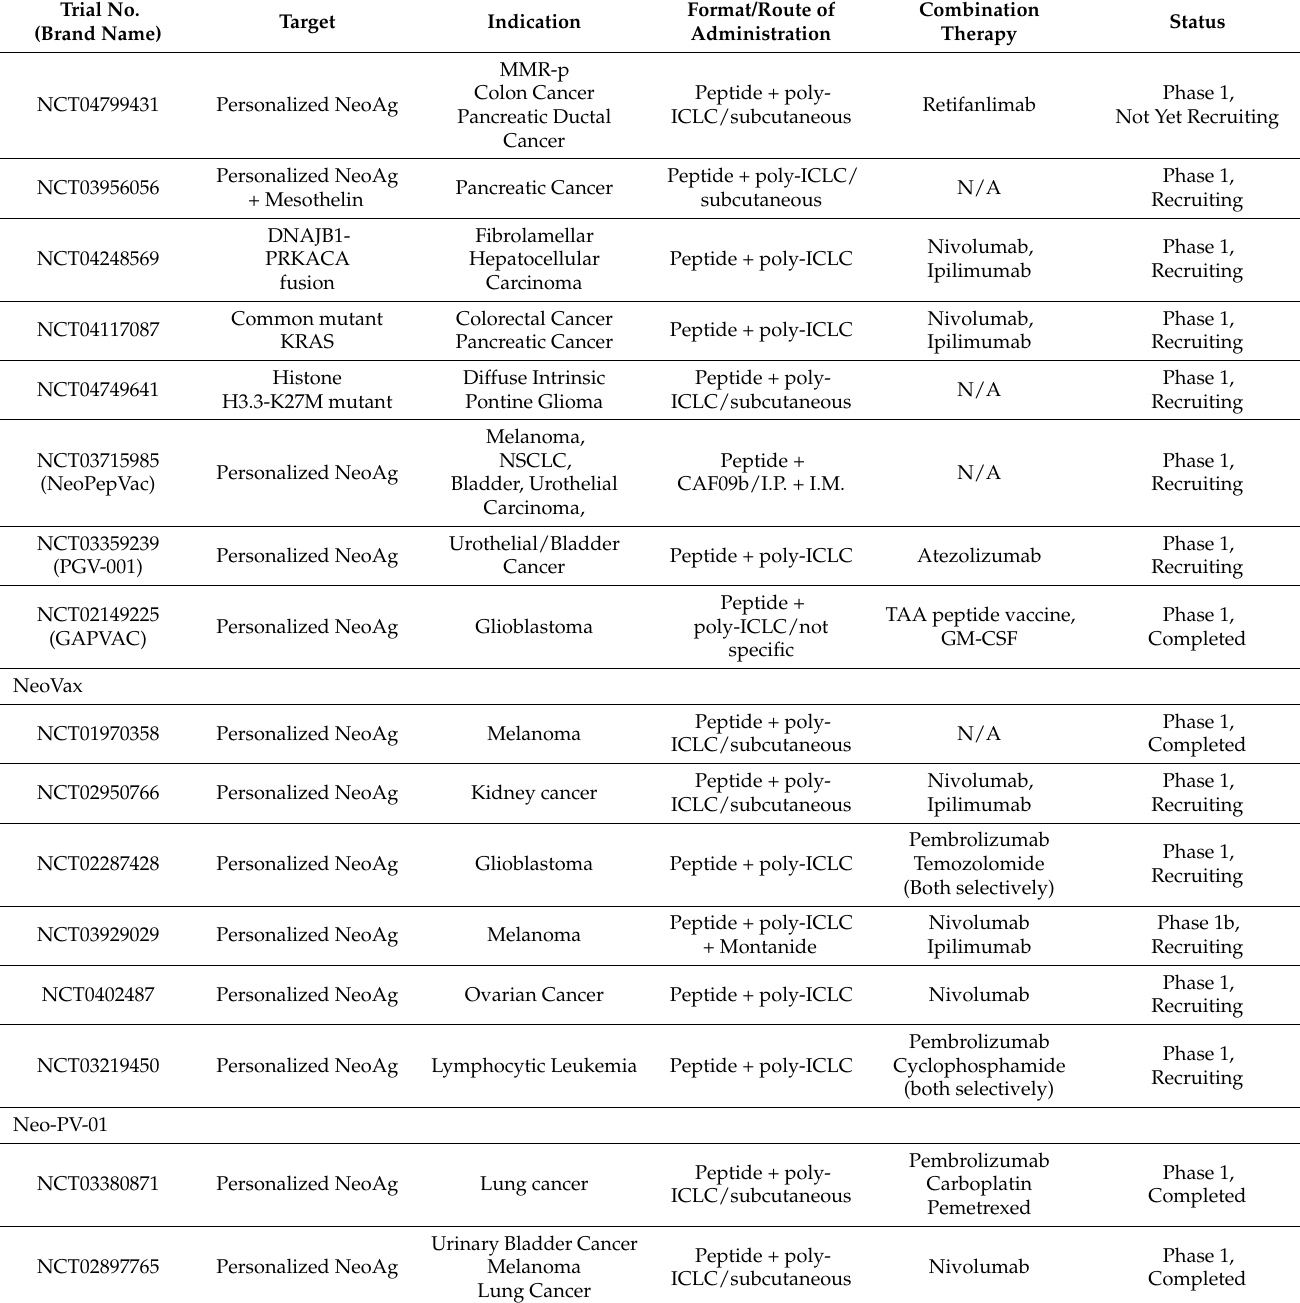
Table 4. Clinical trials of neoantigen-peptide